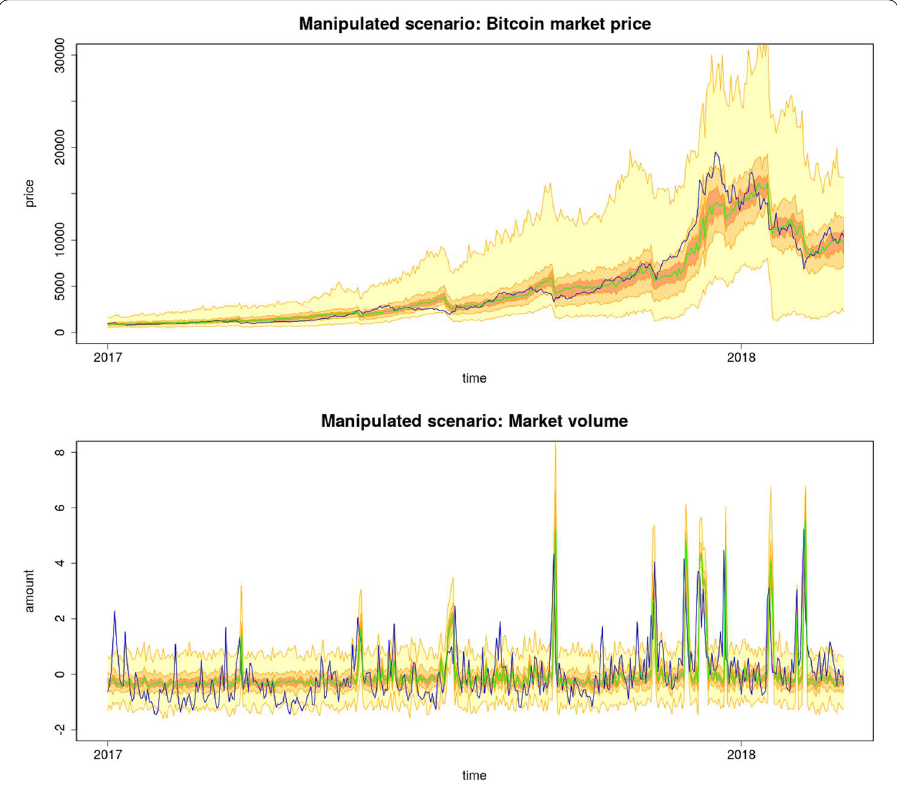
Fig. 5 Simulated market price and market volume with Fraudulent agent included during the simulation, along with the large scale events and all the agents of the response model. The empirical data (blue) are plotted against simulated median (green) with 20th, 50th and 95th prediction